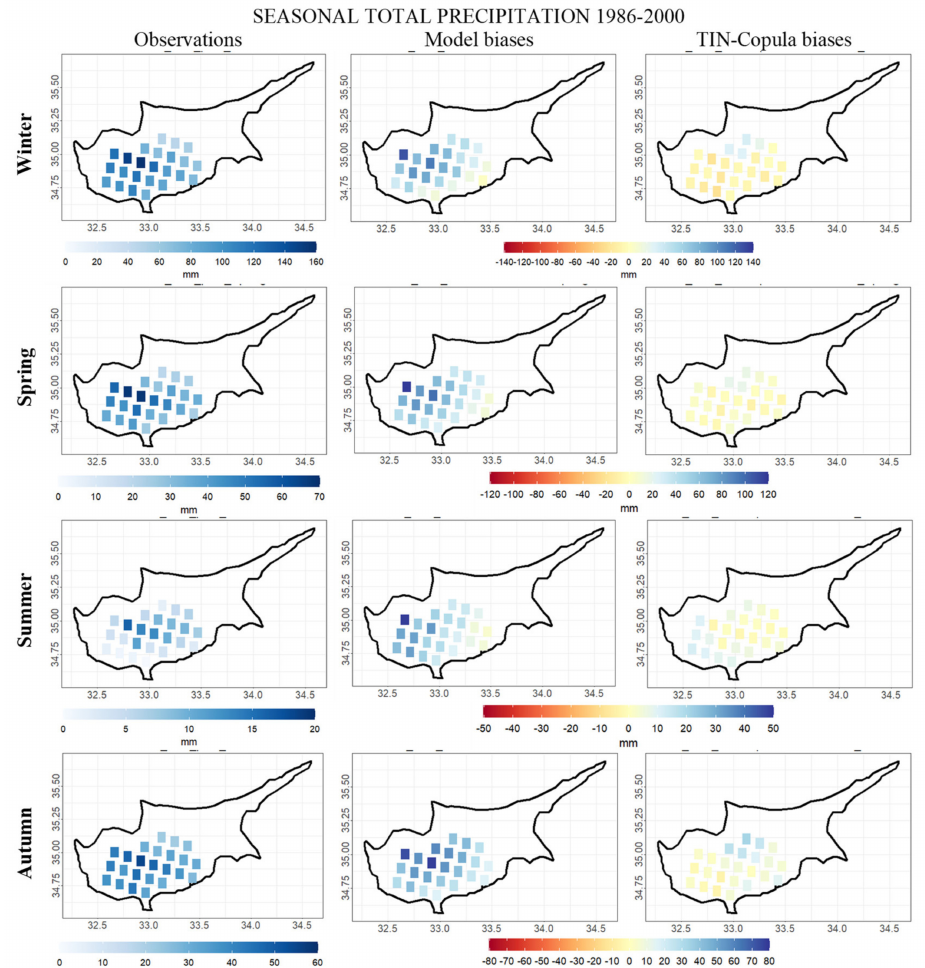
Figure 4. (Left maps) Observed seasonal total precipitation values. (Right maps) Biases between observations and the model’s estimations before and after bias correction